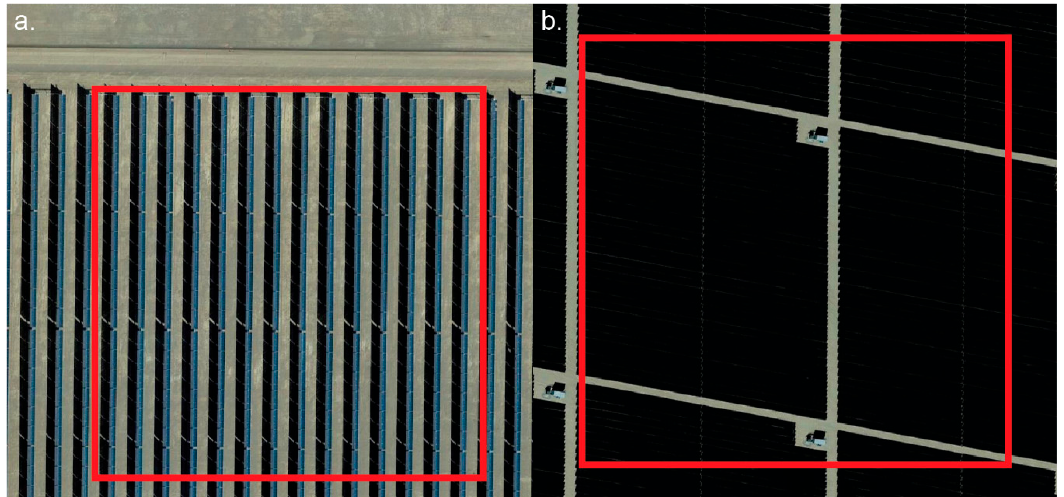
Figure 2. ( a ) Genesis site. Wider array spacing is representative of the McCoy and Imperial sites as well. Image from Google Earth, dated 6 February, 2016. ( b ) Desert Sunlight site. Smaller array spacing is representative of the Desert Stateline site as well. Image from Google Earth, dated 6 February 2016. The red boxes are 250 m on all sides, representing the nominal MODIS vegetation index (VI) spatial resolution.